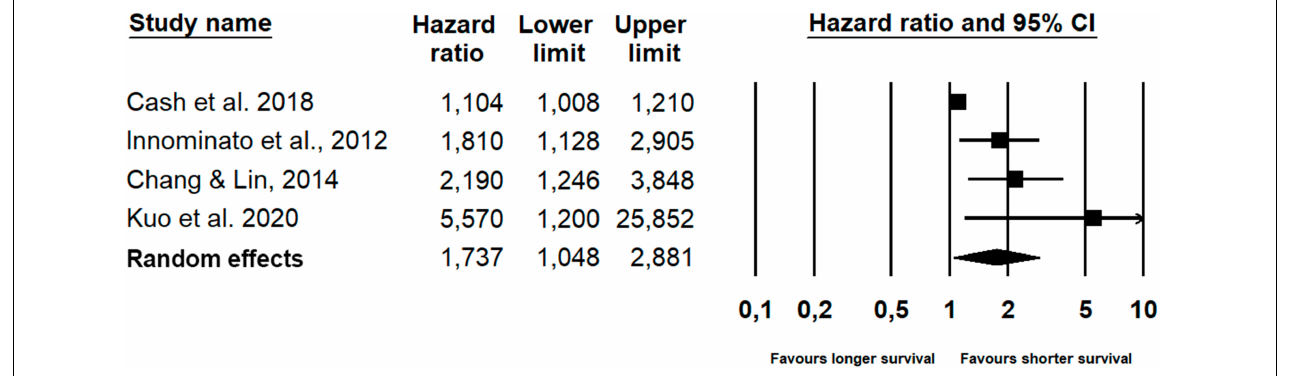
FIGURE 5 | Forest plot of poorer objective sleep and